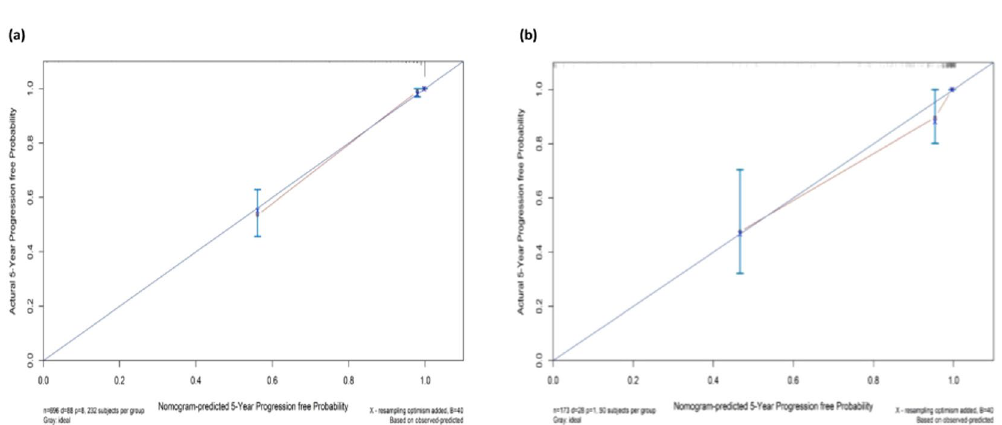
Figure 3. The calibration curves of the nomogram for predicting the 5-year prognosis of IgAN patients in the development cohort ( a ) and validation cohort ( b ). The X-axis represents the nomogram-predicted probability of progression, and the Y-axis represents the actual probability estimated with the Kaplan-Meier method. The blue line represents the ideal correlation between nomogram-predicted and actual